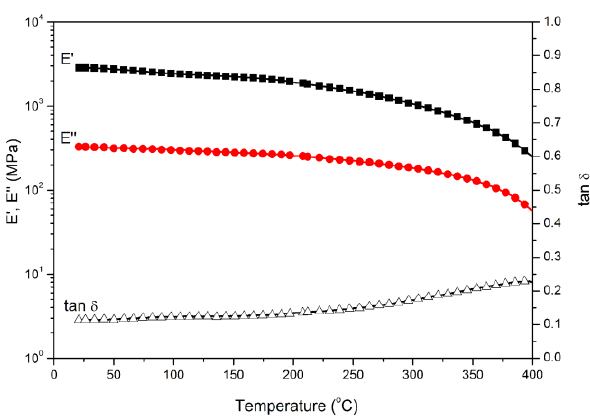
Figure 4. Dynamic mechanical spectra of poly(Dd-hda) Xmain .